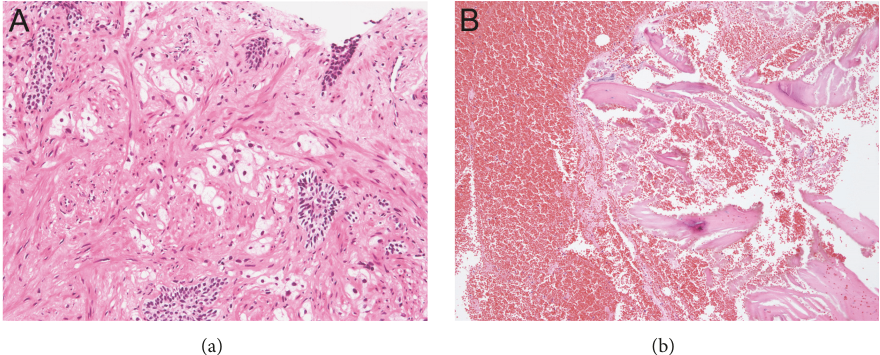
Figure 4: Histopathological findings at the time of CRPC diagnosis. Prostate needle biopsy detected viable prostate cancer cells from 10 of 12 cores (a). Bone needle biopsy from the second lumbar vertebra demonstrated no malignant cells (b). CRPC, castration-resistant prostate